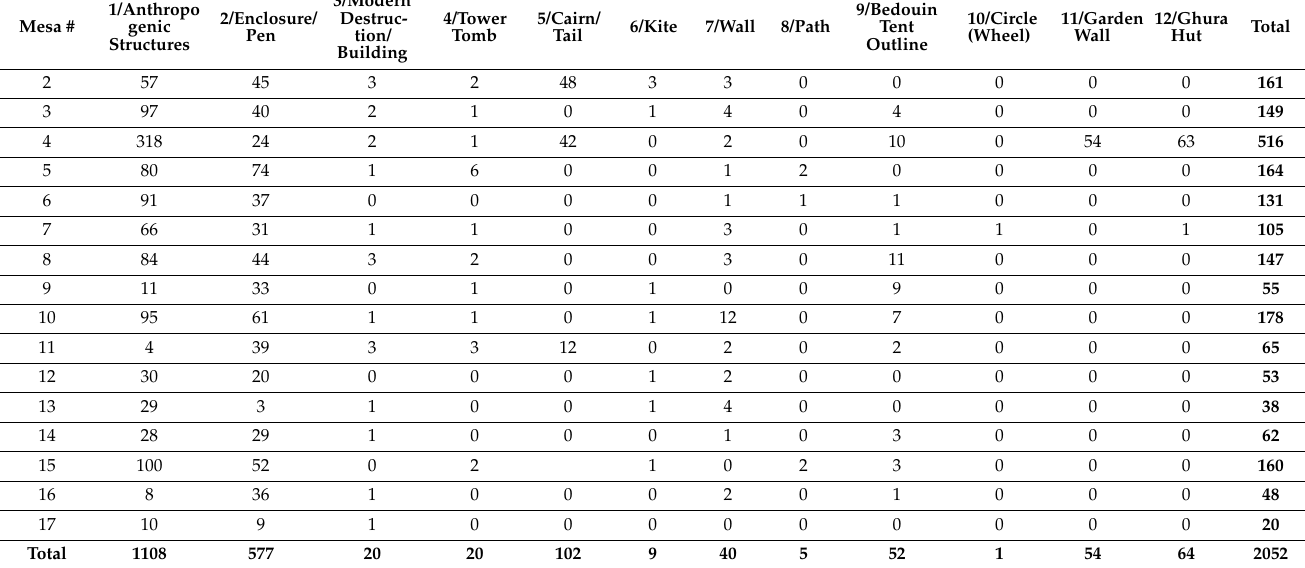
Table 1. Total count of various types of features recorded in the survey